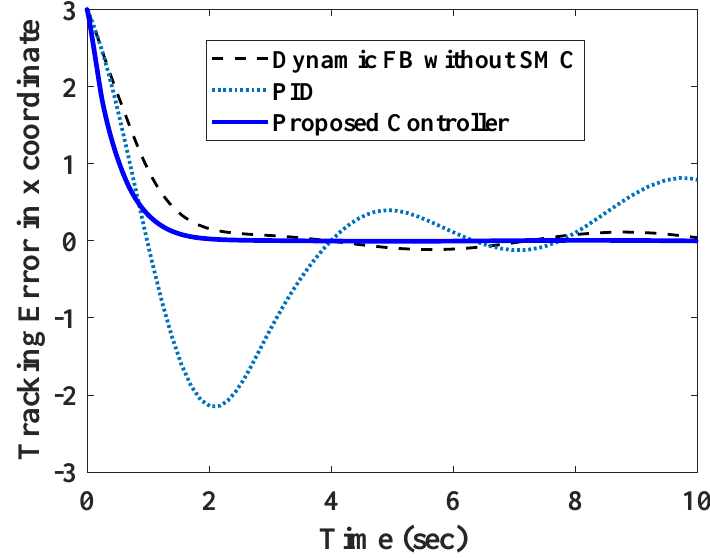
Figure 10. Comparison of position error in x